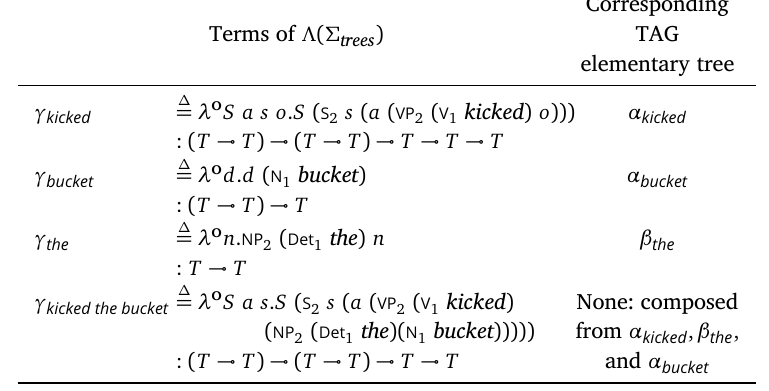
Constants of (cid:6) derivations and their interpretation by G derived trees and G sem.